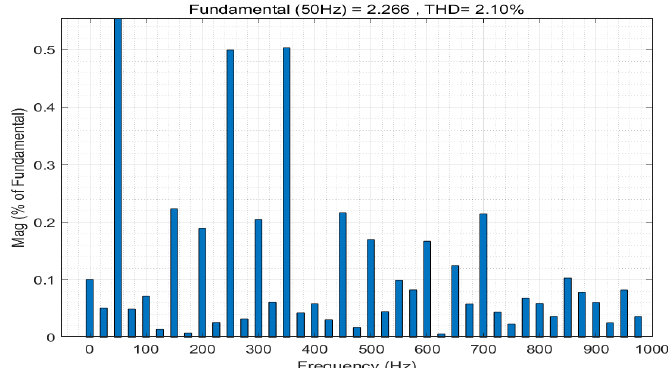
Figure 7. Spectrogram of supply current in steady state at 0.2 s.